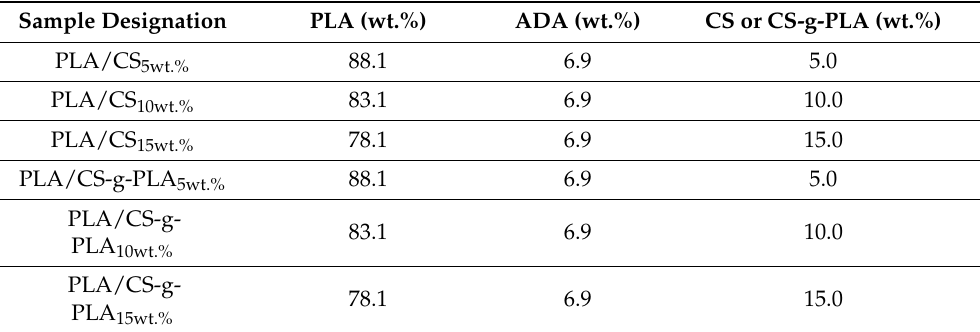
Table 1. Weight composition of PLA/CS and PLA/CS-g-PLA